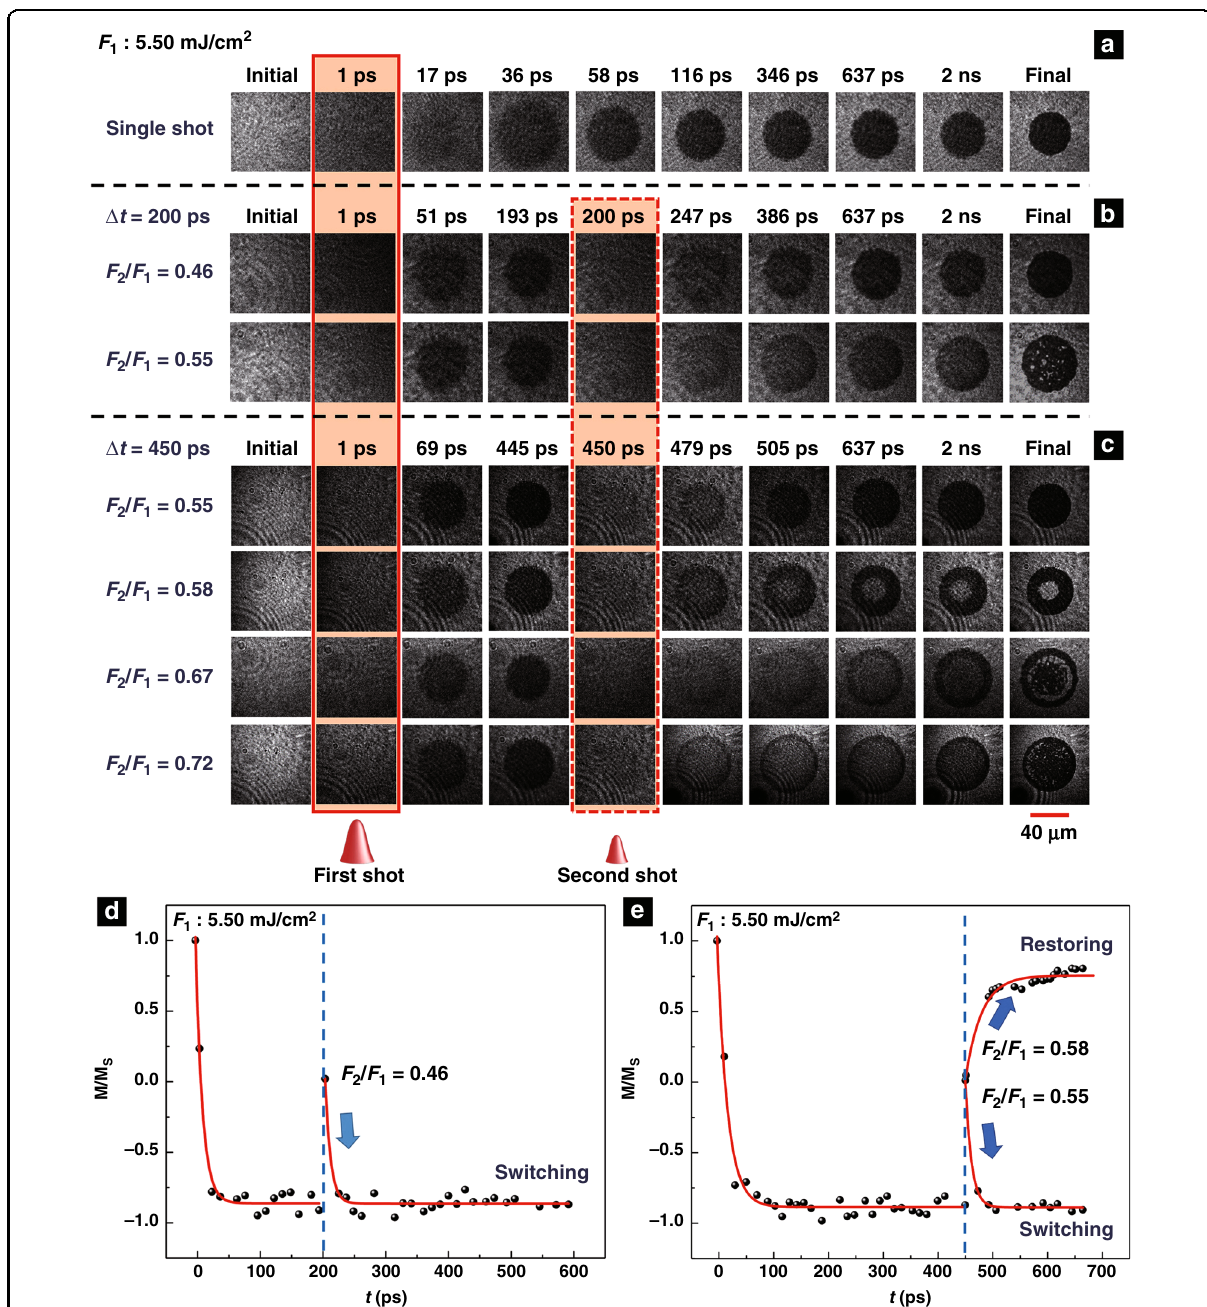
Fig. 3 The magnetization dynamics of Gd 27 Fe 63.87 Co 9.13 observed by the time-resolved imaging technique. a – c The magnetization dynamics of Gd 27 Fe 63.87 Co 9.13 under single-shot excitation ( a ) and dual-shot excitation ( b , c ). The solid and dashed red frames indicate the images acquired at the arrivals of the fi rst and second shots, respectively. The scale bar is 40 μ m. d , e The normalized magnetization in the centres of the switched areas extracted from the images in b , c . The red lines are guides for the eye. Δ t in b and d , and in c and e is 200 ps and 450 ps,